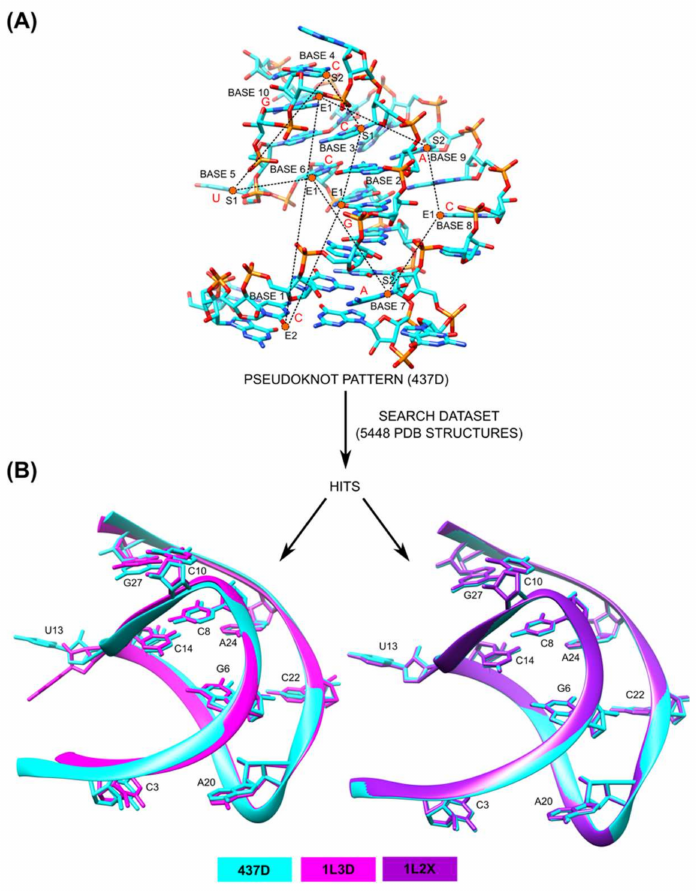
Figure 8. Annotation of pseudoknot motifs in RNA structures from PDB by NASSAM. ( A ) The 28 nucleotides (components) of a pseudoknot motif from the beet western yellow virus (PDB ID: 437D). The components selected to construct the pattern are labeled as Base 1 to Base 10. The red- colored letters indicate component types, either A, G, U, or C. The pseudo-atoms of the pattern are denoted as graph nodes (orange circles), and the distances between pseudo-atoms are denoted as graph edges (black dashed lines). Only a few of the pseudo-atoms and their distances are shown for clarity. ( B ) The pattern (PDB ID: 437D) base arrangements, shown as cyan-colored stick structures, are superimposed to the base arrangements of hits (PDB ID: 1L3D, 1L2X) shown as magenta-colored and purple-colored stick structures, respectively. The bases are labeled based on the sequence identifiers of the hit structures. The superimpositions of the backbones between the pattern and the hits are also shown to illustrate that the hits adopt pseudoknot